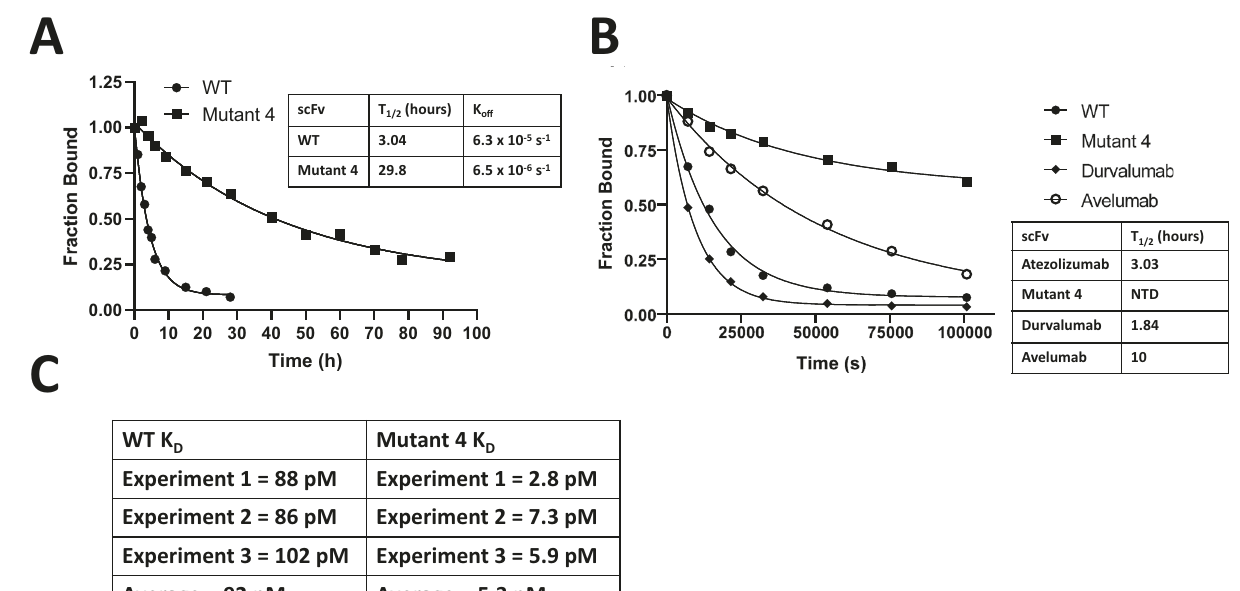
Fig.8|Determinationoftheoff-rateand K D ofmutant4. Experimentalvalidation of the K off and K D on the yeast surface. A WT vs. Mutant 4 scFv dissociation after 92h atRTonthe yeast surface, T 1/2 ishalf-life. B ComparisonofWT Atezolizumab, Mutant4,Durvalumab,andAvelumabscFvdissociationover28hatRTontheyeast